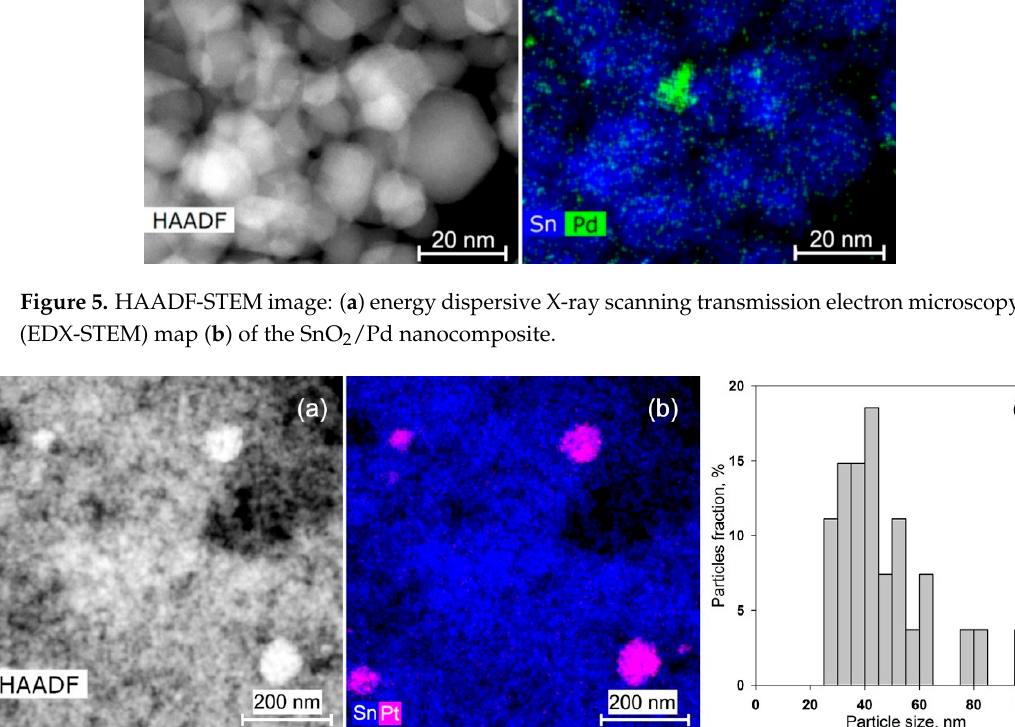
Figure 6. HAADF-STEM image: ( a ) EDX-STEM map ( b ) and Pt particles size distribution ( c ) of the SnO 2 /Pt nanocomposite.